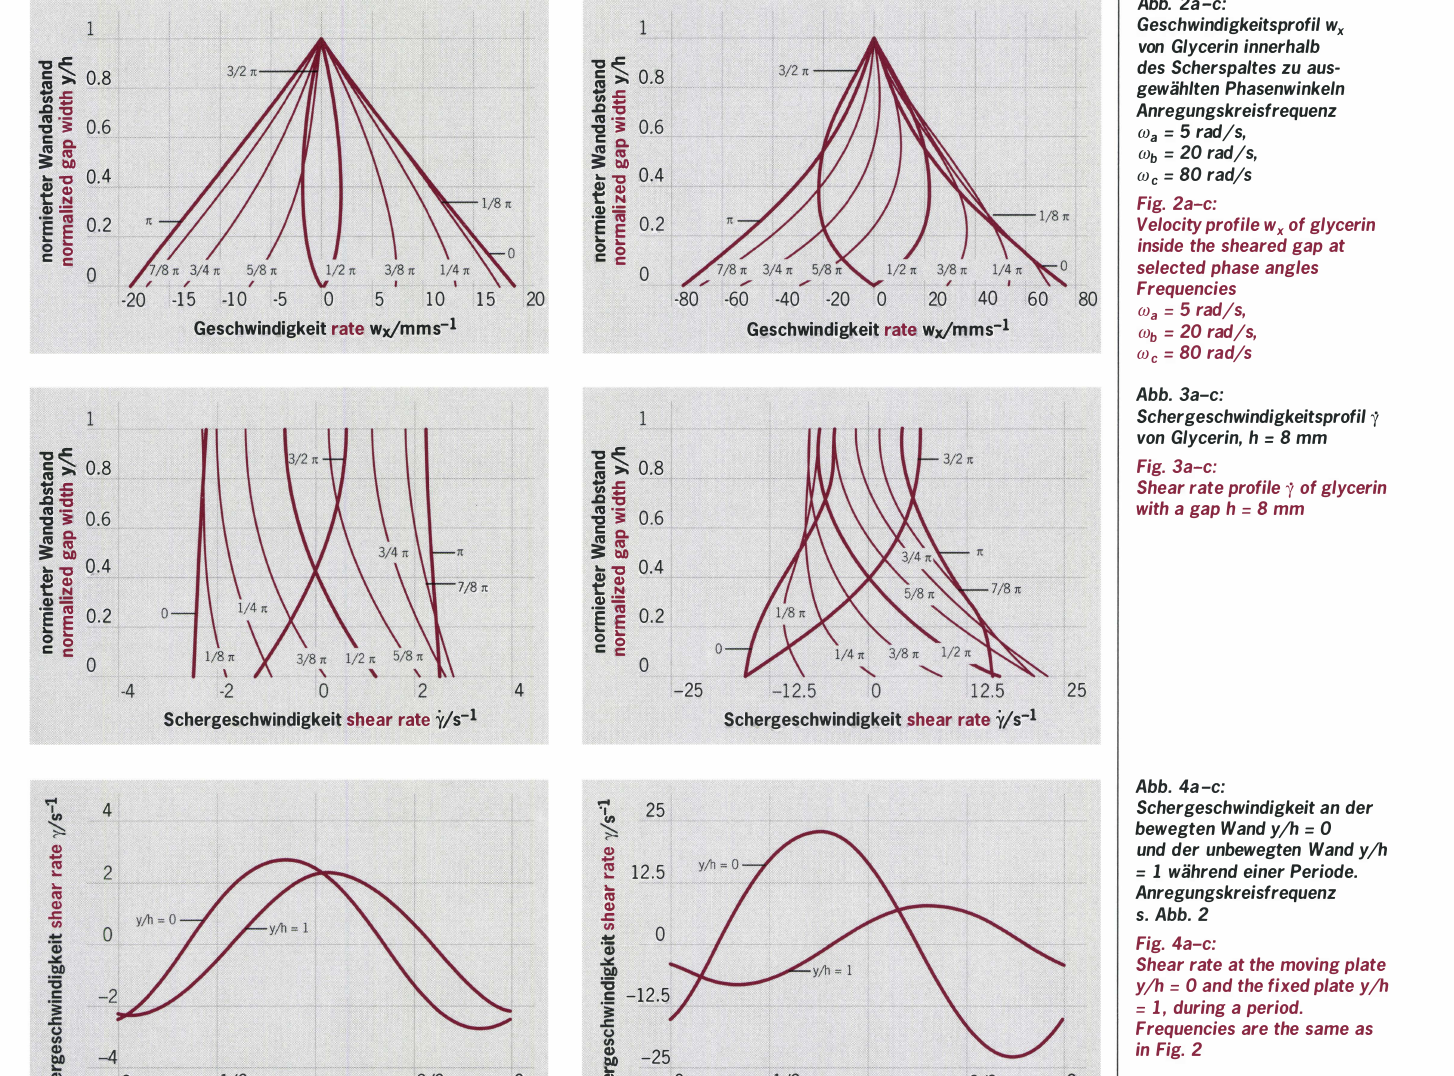
Abb. 4a-c: Schergeschwindigkeit an der bewegten Wand yjh = 0 und der unbewegten Wand yjh = 1 wiihrend einer Periode. Anregungskreisfrequenz s. Abb. 2 Fig. 4a-c: Shear rate at the moving plate yjh = 0 and the fixed plate yjh = 1, during a period. Frequencies are the same as in Fig.